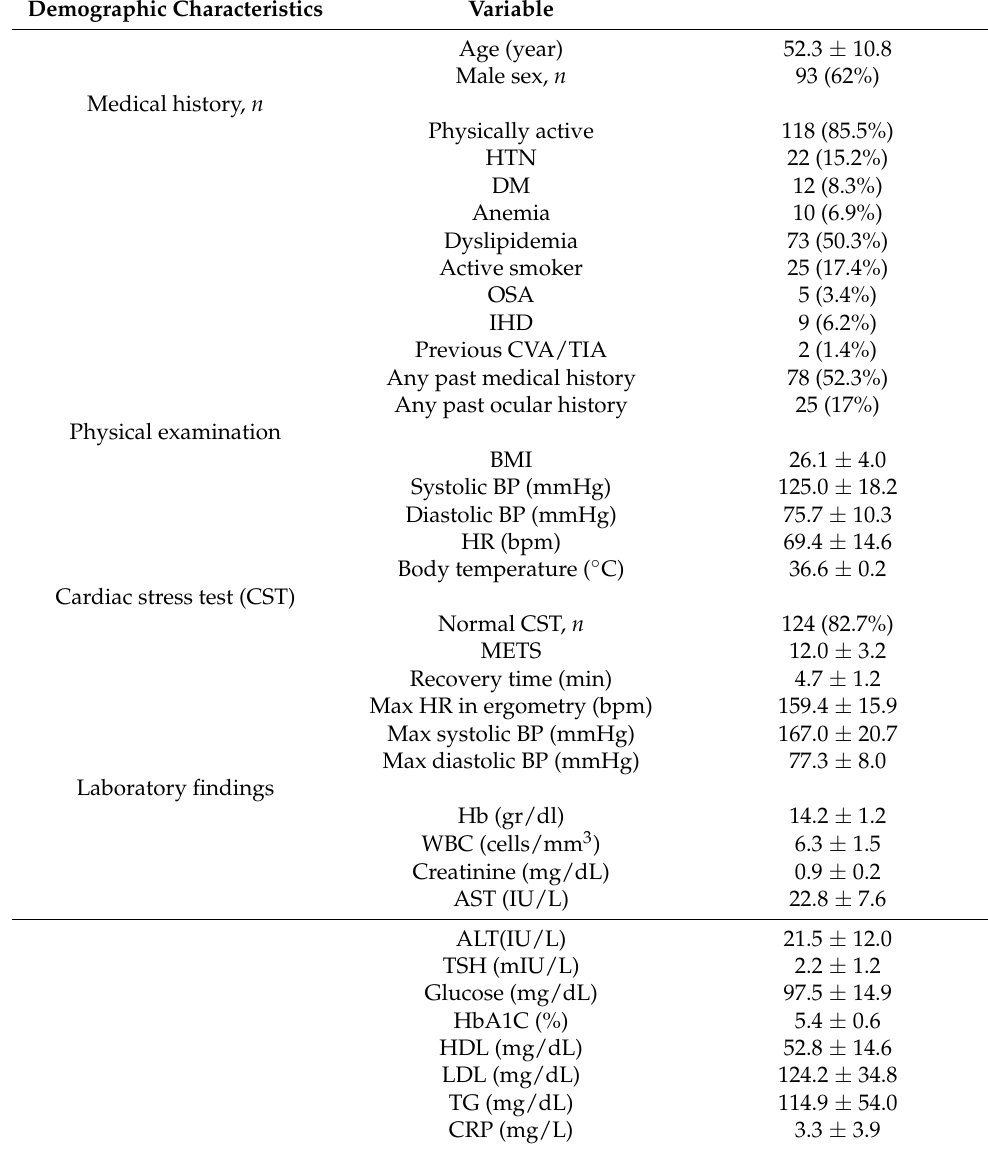
Table 1. Demographic and clinical characteristics and laboratory findings. Demographic